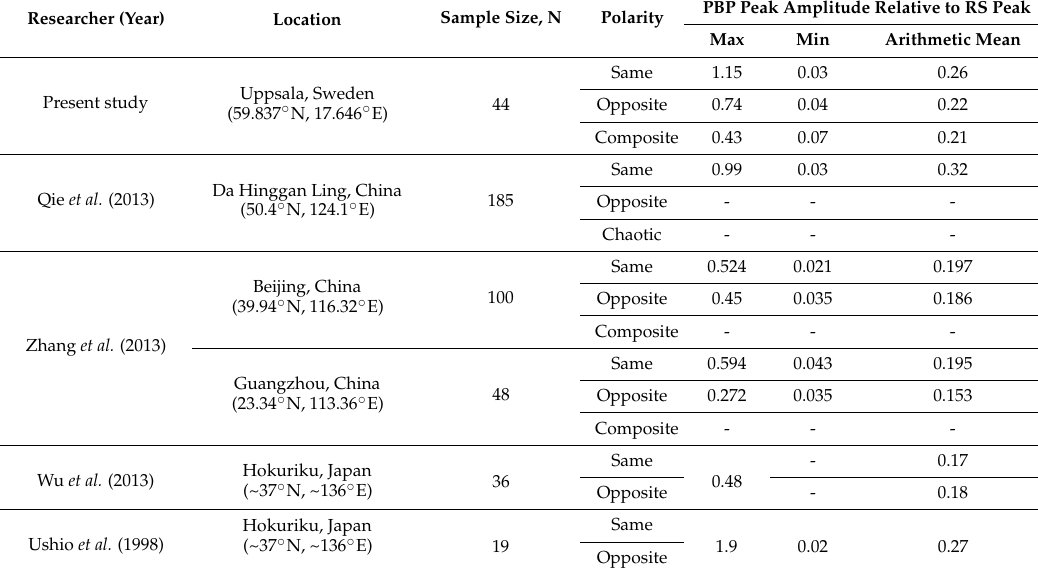
Table 4. Comparison on PBP peak amplitude relative to return stroke peak with previous